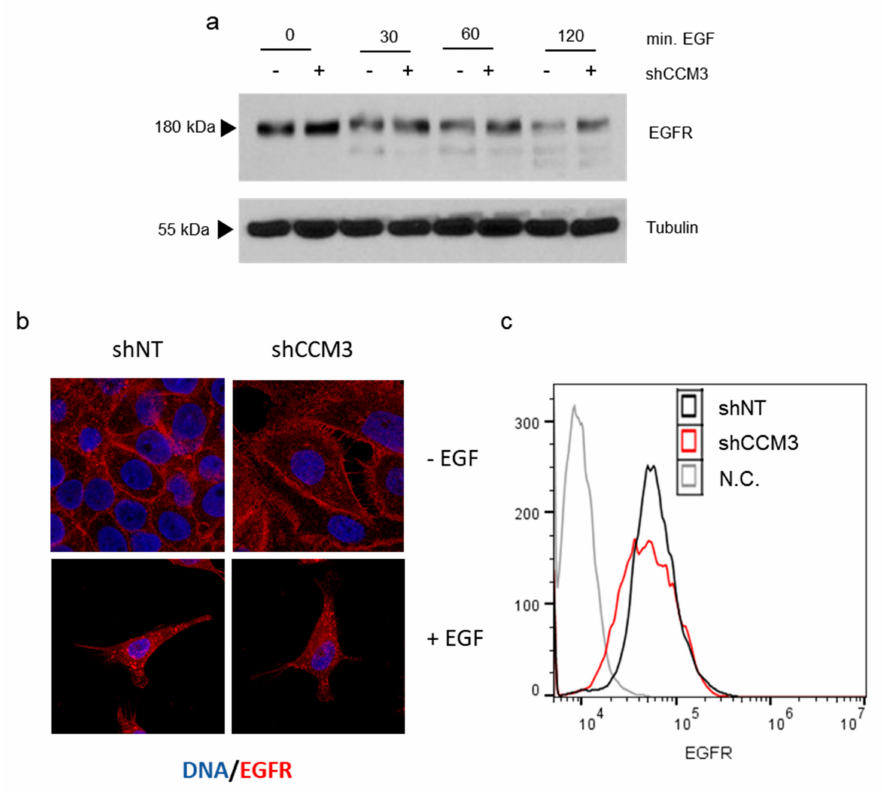
Figure 4. EGFR endocytosis is not inhibited in CCM3-deficient cells. ( a ) hCMEC / D3 endothelial cells transduced with shNT and shCCM3 shRNAs were serum deprived and treated with 100 ng / mL EGF for the indicated times, and EGFR levels were analyzed by Western blot; ( b ) A549 cells transduced with shNT and shCCM3 shRNAs were serum deprived and then treated or not with EGF 100 ng / mL previously. Then, cells were stained for immunofluorescence analysis of EGFR (red) expression and distribution. Images were captured at 63 × and merged with DAPI (blue). ( c ) A549 cells transduced with shNT and shCCM3 shRNAs were serum deprived and the EGFR in their plasma membrane measured by flow cytometry.